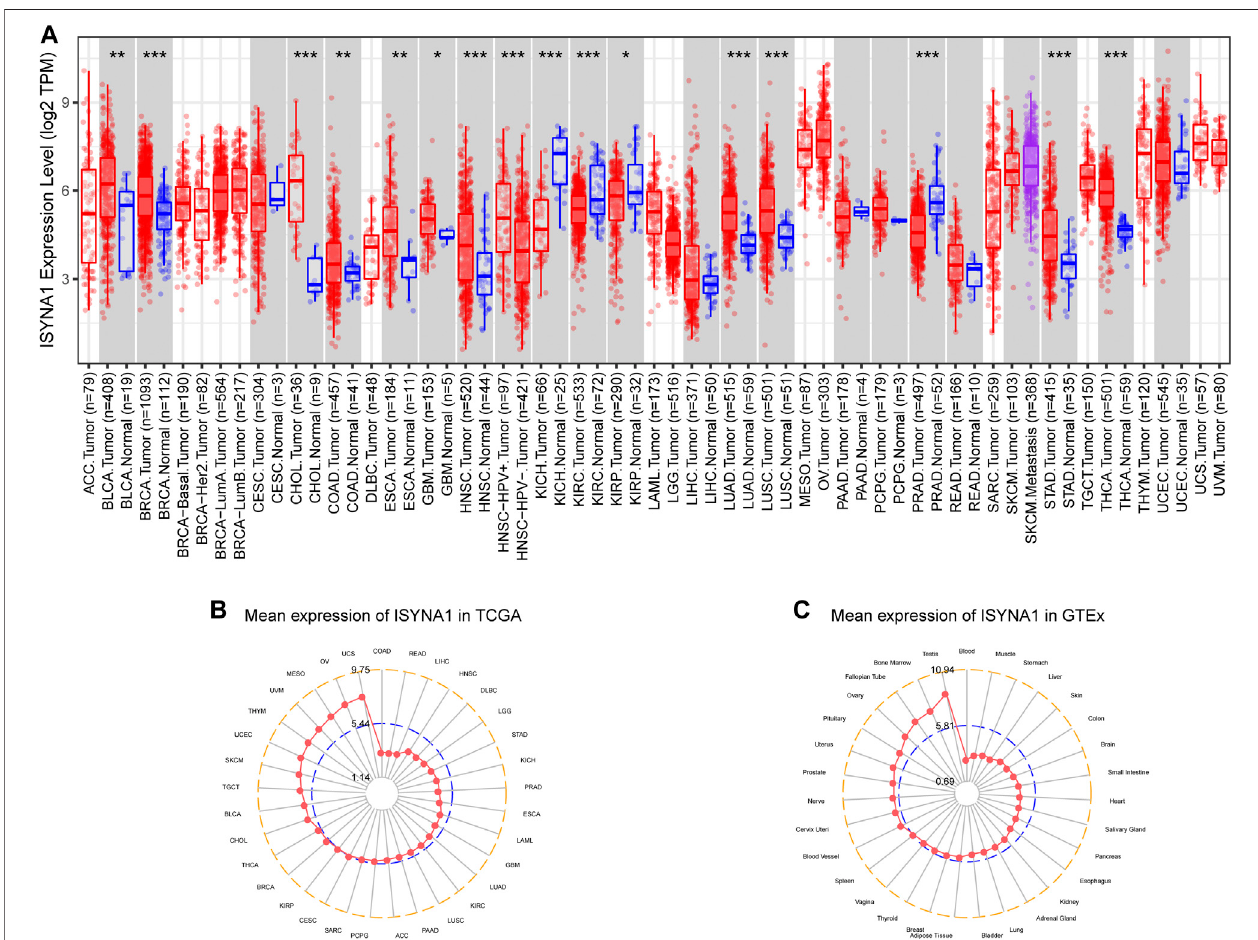
FIGURE1|(A) Pan-cancerexpressionofISYNA1. (B) ISYNA1expressionintumortissuesfromTCGAcohort. (C) ISYNA1expressioninnormaltissuesfromGTEx cohort. * p < 0.05, ** p < 0.01, *** p < 0.001, **** p < 0.0001.